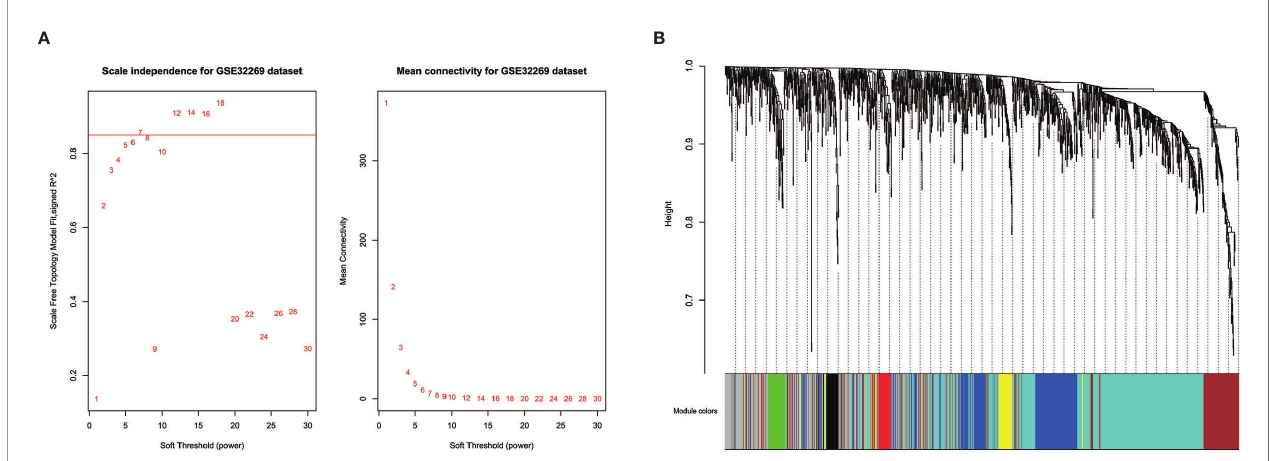
FIGURE 3 | Identi fi cation of modules in the dataset GSE32269. (A) Network topology of different soft-thresholding powers. The left panel displays the in fl uence of soft-thresholding power (x-axis) on scale-free fi t index (y-axis). The right panel shows the in fl uence of soft-thresholding power (x-axis) on the mean connectivity (degree, y-axis). (B) Clustering dendrogram showing eight modules that contain a group of highly connected genes. Each designated color represents a certain gene module.